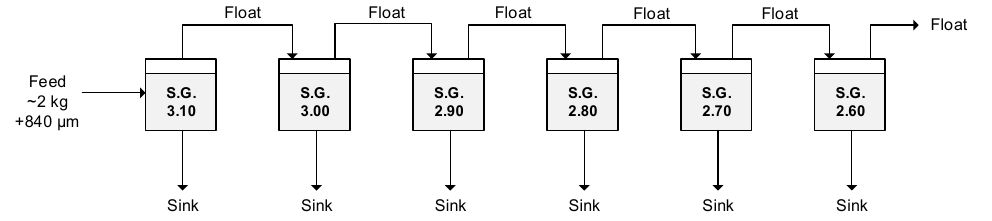
Figure 2. Heavy liquid separation testing procedure.